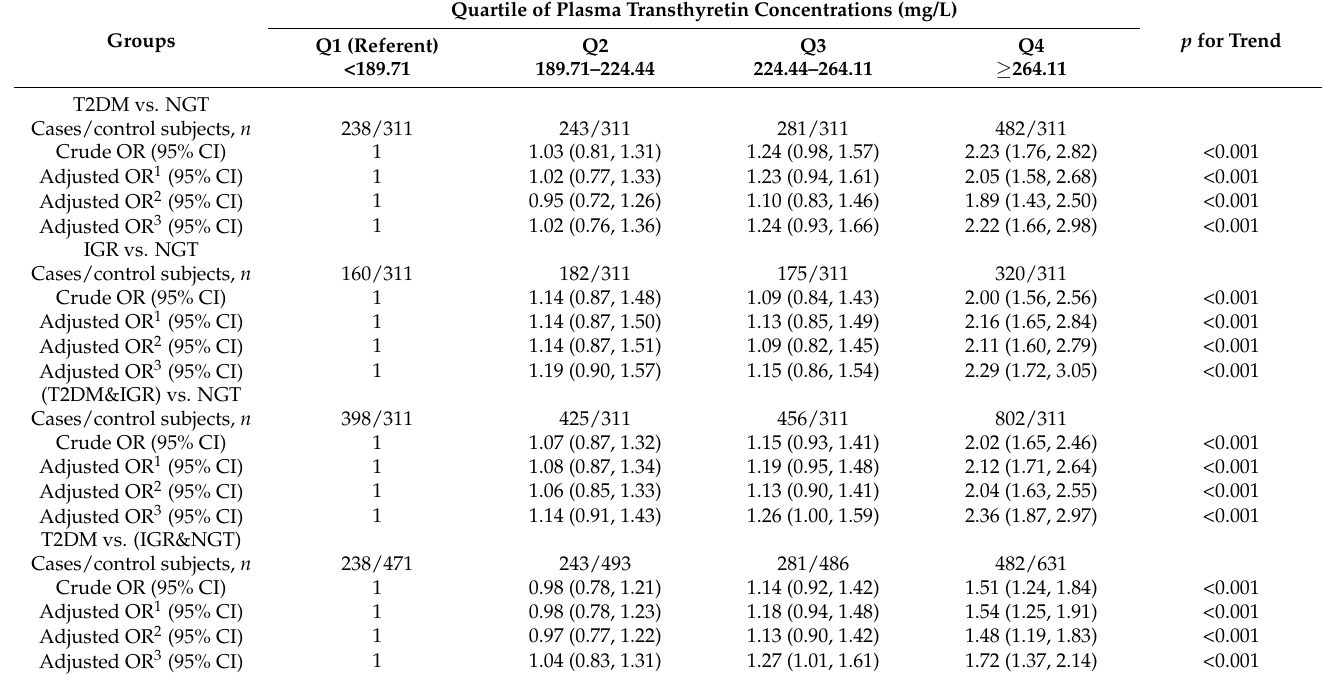
Table 2. Odds ratios of T2DM and IGR, by quartiles of plasma transthyretin concentrations.